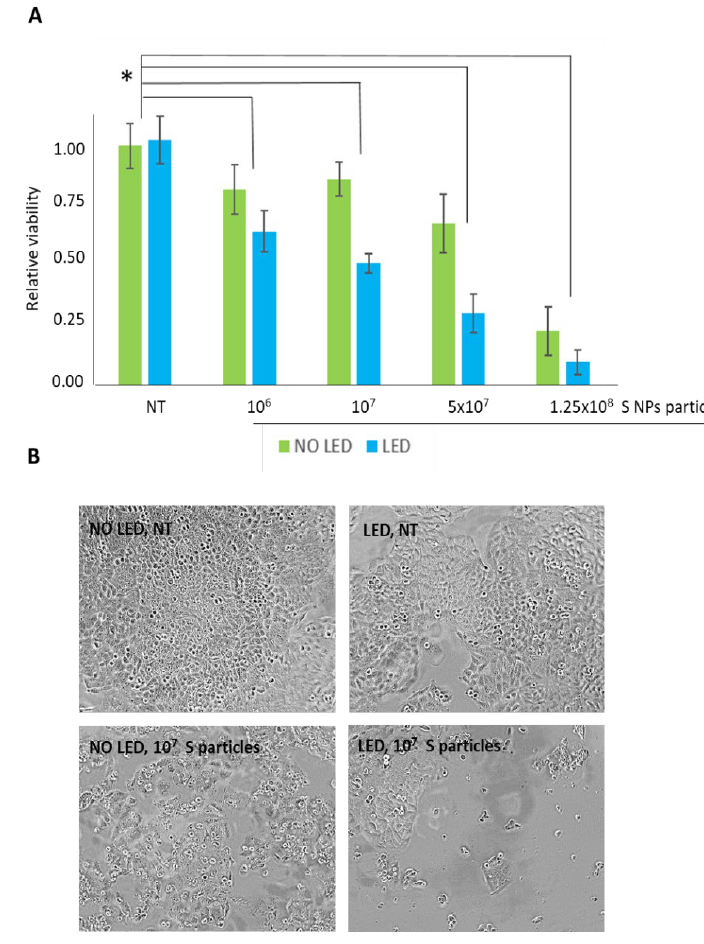
Figure 11. Viability effect of NP BBR S in T98G cells. ( A ) Different amounts of NP BBR S were assayed in MTS viability and compared to untreated cells (NT), in the presence or absence of LED stimulation (4 min at 447 nm and 1.2 mW/cm 2 of intensity). The asterisk (*) indicates statistical significance compared to untreated cells ( p < 0.05, one-way ANOVA). ( B ) Representative images comparison of untreated cells (stimulated or not with LED) and cells following 10 7 NP BBR S